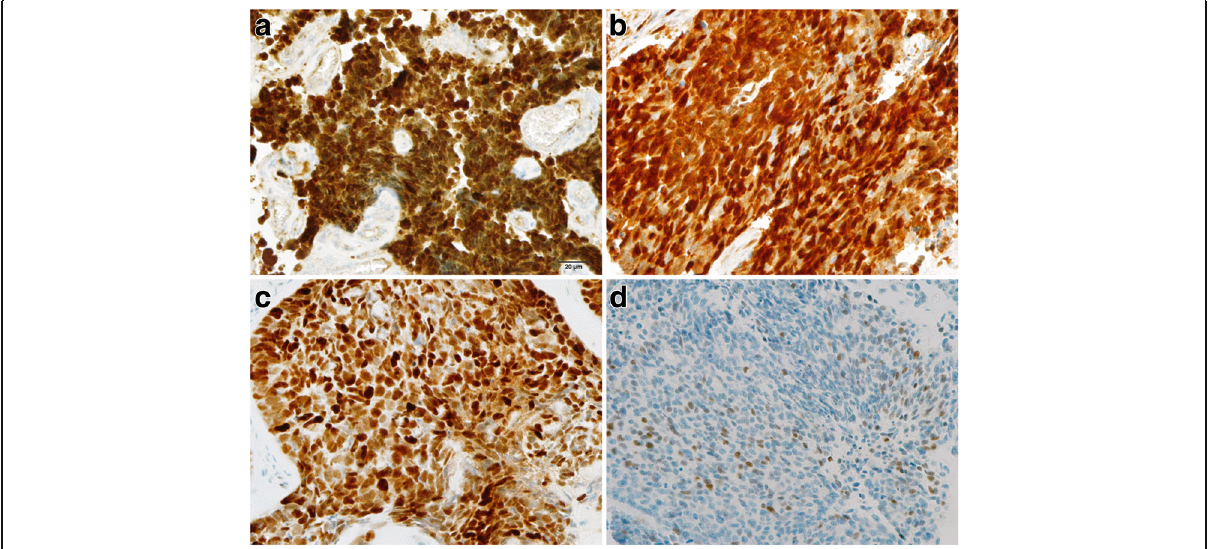
Fig. 5 Immunohistochemical expression of p16 and p53 (× 400). Strong and diffuse nuclear and cytoplasmic staining for p16 was noted in cervical small cell carcinoma ( a ) and squamous cell carcinoma ( b ). c Nuclear staining for p53 was observed in cervical squamous cell carcinoma, wich revealed TP53 missense mutation. d Cervical small cell carcinoma illustrating scattered, weakly positive nuclear staining for p53 revealed wild type pattern of